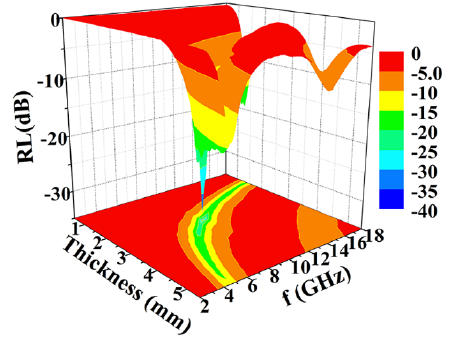
Figure 5. Three-dimensional representation of the RL derived from the measured and of the FCC-Co/C nanocapsules-paraffin composites as a function of the frequency.